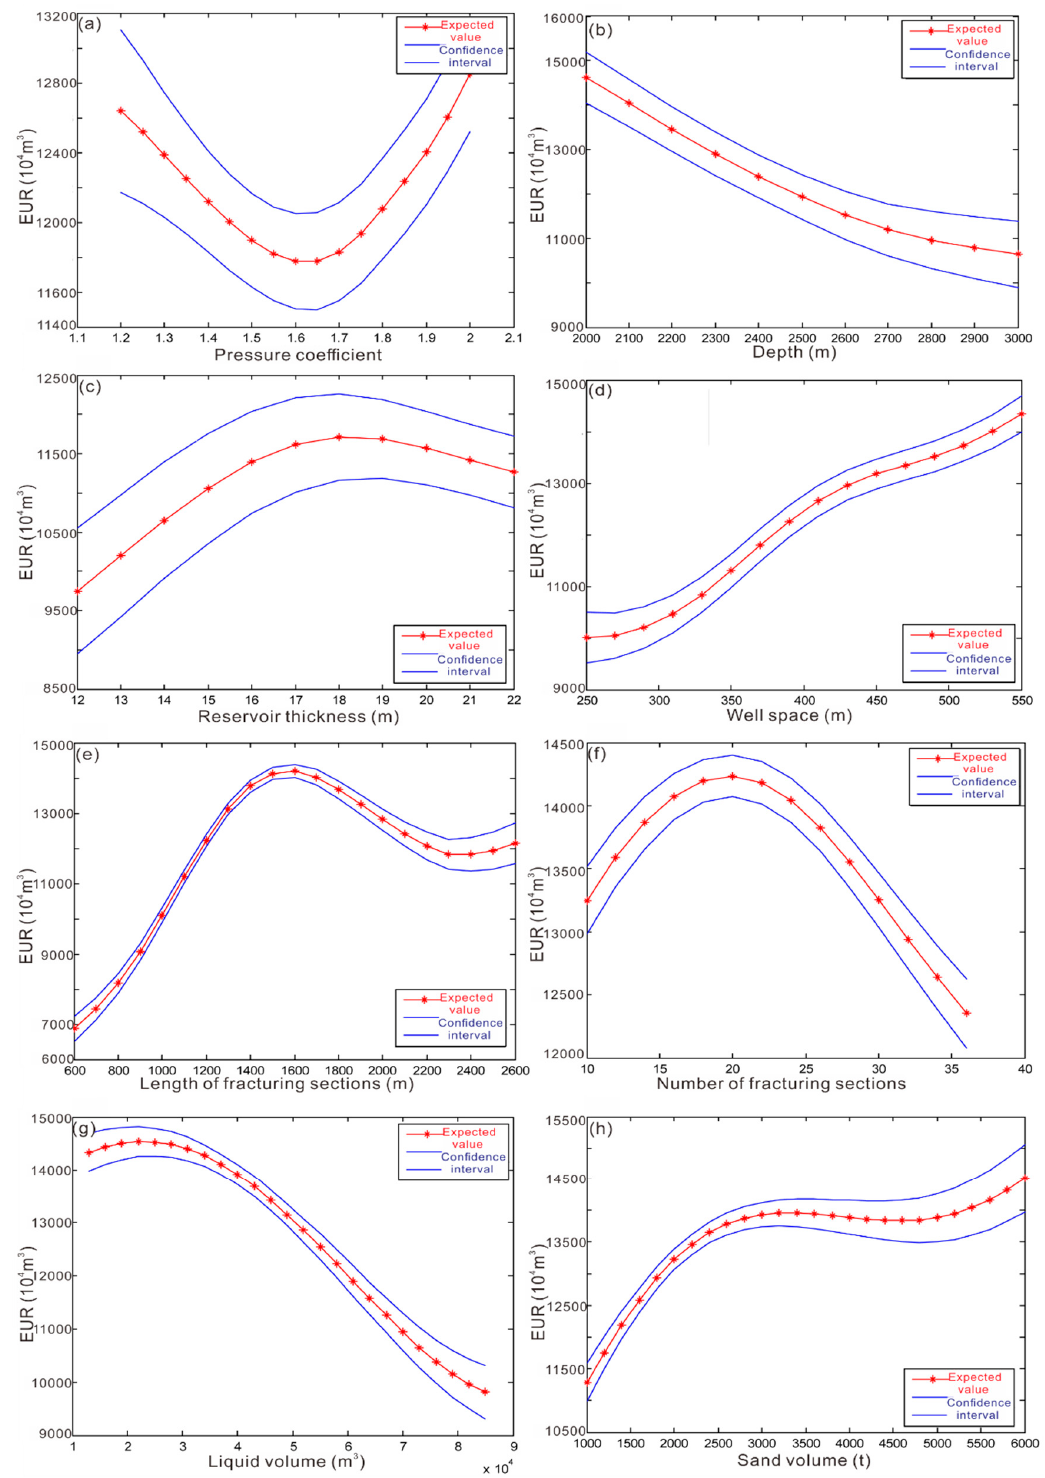
Figure 5. Fitted expected value and interval of 50% confidence coefficient on random BP neural network for a standard well in Changning block. ( a ) Relationship between EUR and pressure coeffi- cient; ( b ) relationship between EUR and depth; ( c ) relationship between EUR and reservoir thickness; ( d ) relationship between EUR and number of well space; ( e ) relationship between EUR and length of fracturing sections; ( f ) relationship between EUR and number of fracturing sections; ( g ) relationship between EUR and liquid volume; ( h ) relationship between EUR and sand